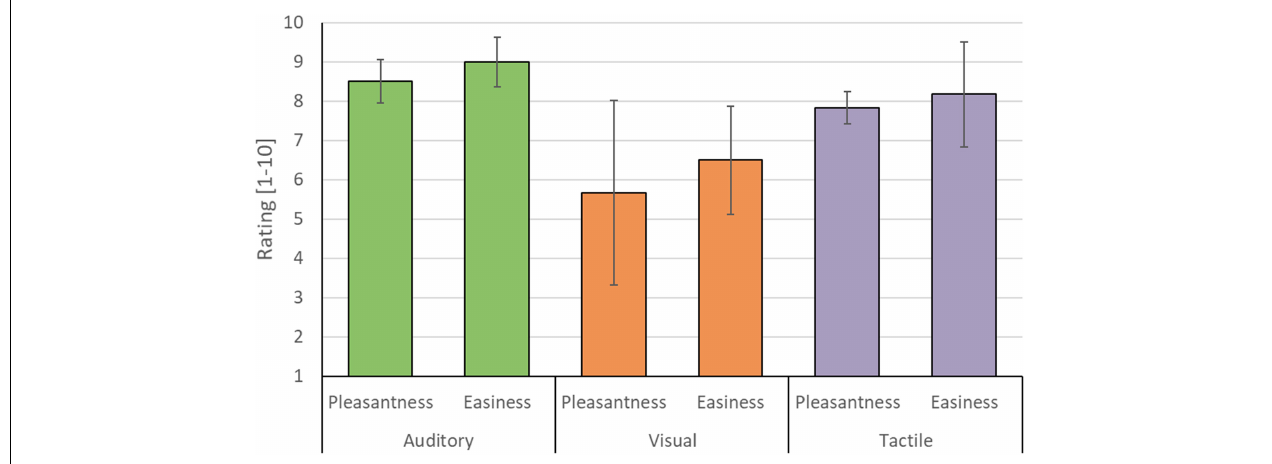
FIGURE 10 | Mean participant rating of perceived pleasantness and easiness for each of the three sensory encoding modalities. Participants rated the auditory (green), visual (orange), and tactile modality (purple) on a scale from 1 (not pleasant/easy at all) to 10 (very pleasant/easy). Error bars depict the standard deviation of the group mean. Note that the auditory and tactile modality were rated as relatively more pleasant and easy compared to the visual